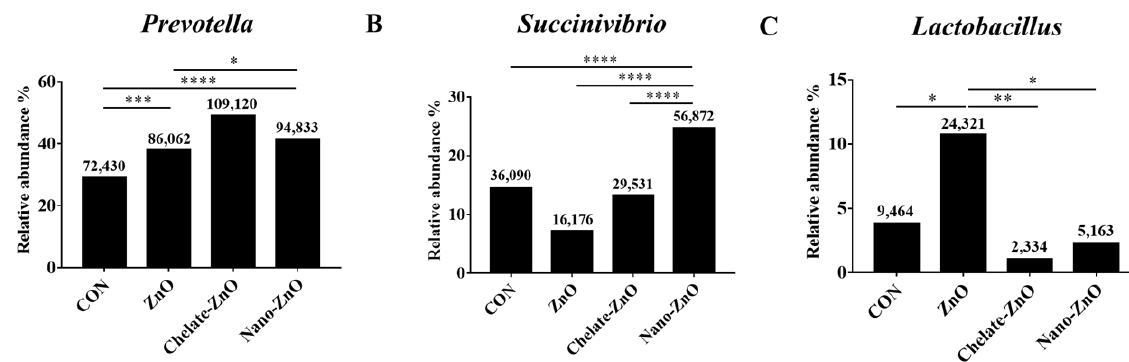
Figure 11. The bar plot identifying the different taxon between control and ZnO treatments. CON, ZnO, chelate-ZnO, and nano-ZnO groups at the genus ( A , B , C ) level were examined. The numbers on each bar indicates the normalized abundance of each strains. * p < 0.05; ** p < 0.005; *** p < 0.001; **** p < 0.0001.